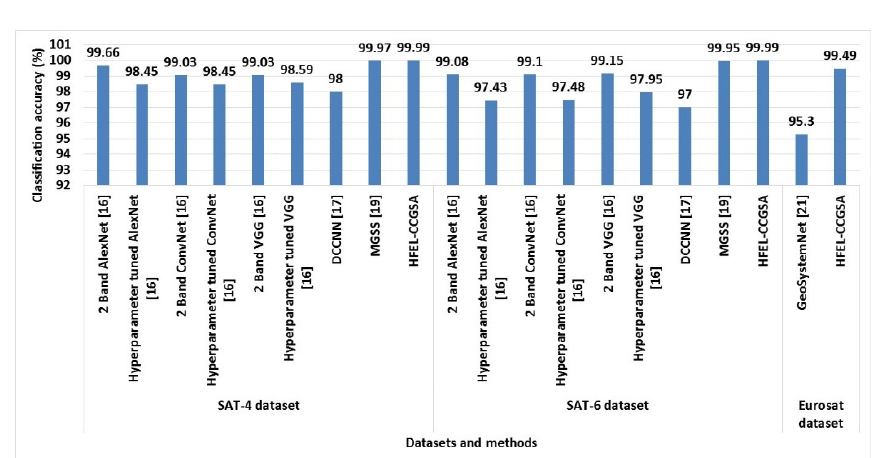
Figure 5. Comparison graph for classification accuracy.